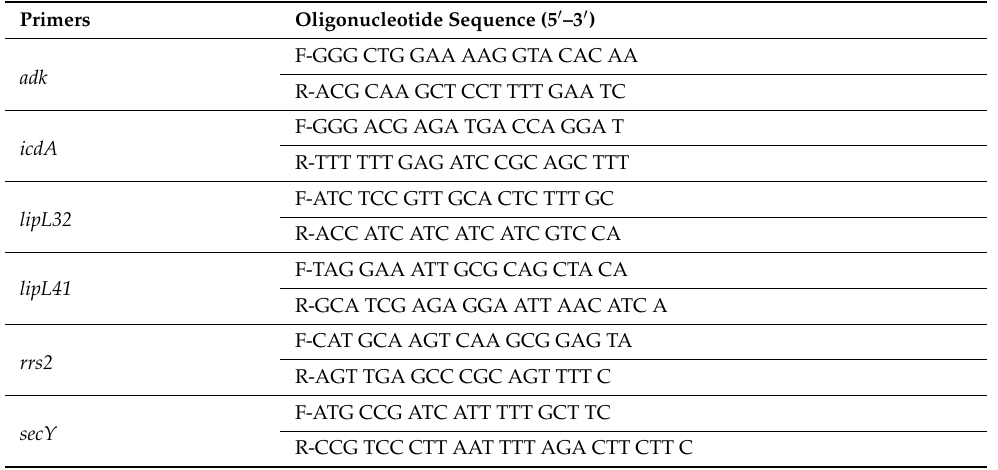
Table 1. Oligonucleotide sequence for both forward and reverse primers in MLST Scheme 3.